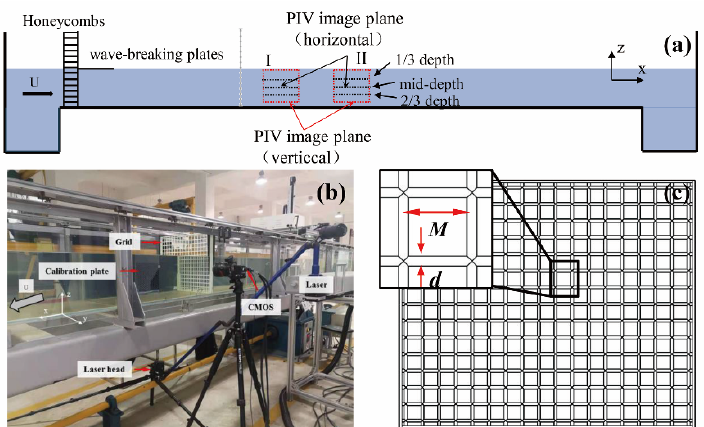
Figure 1. Experimental setup ( a ) side view of water channel; ( b ) photograph of devices and ( c ) grid.